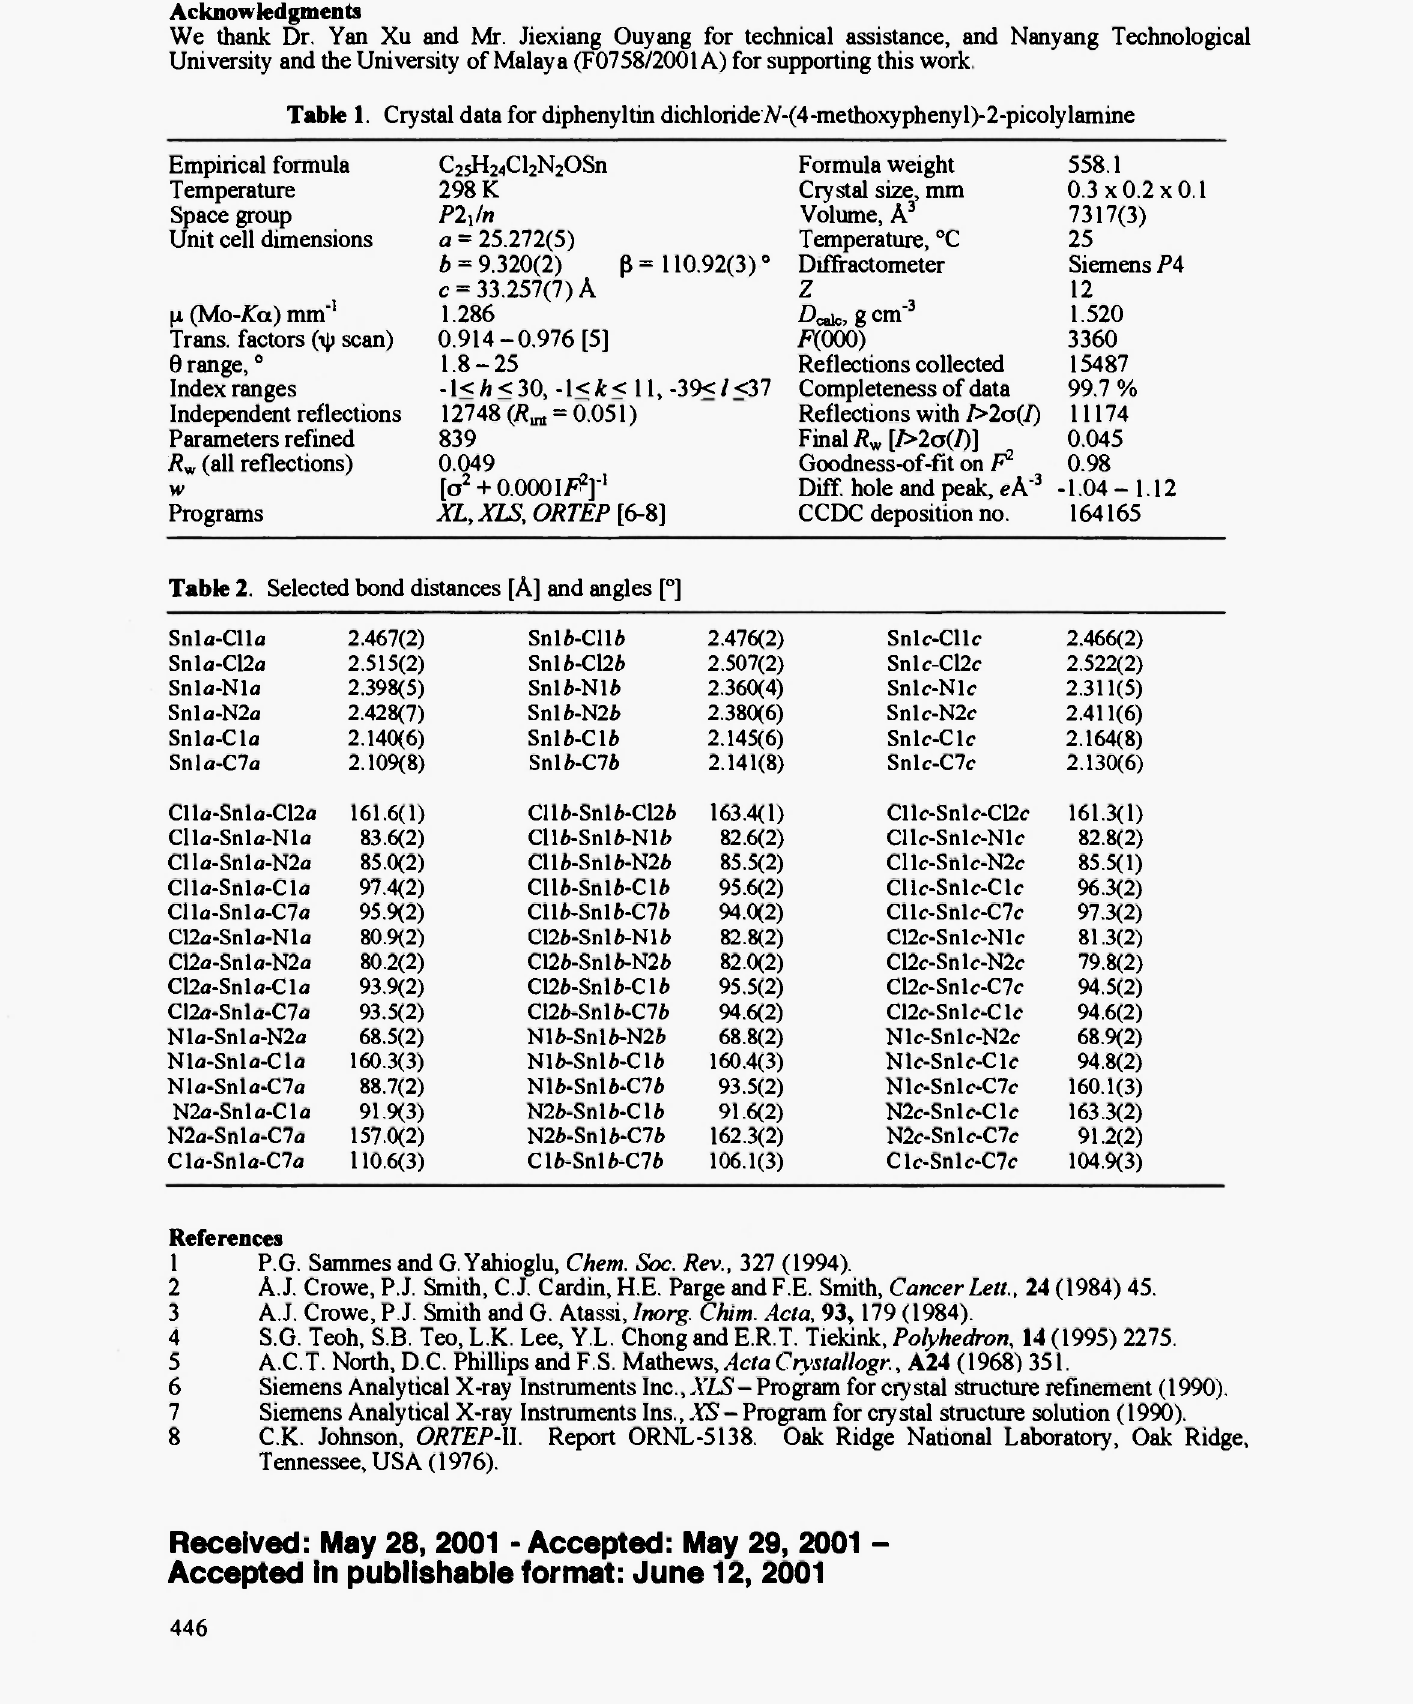
Table 1. Crystal data for diphenyltin dichlorideW-(4-methoxyphenyl)-2-picolylamine